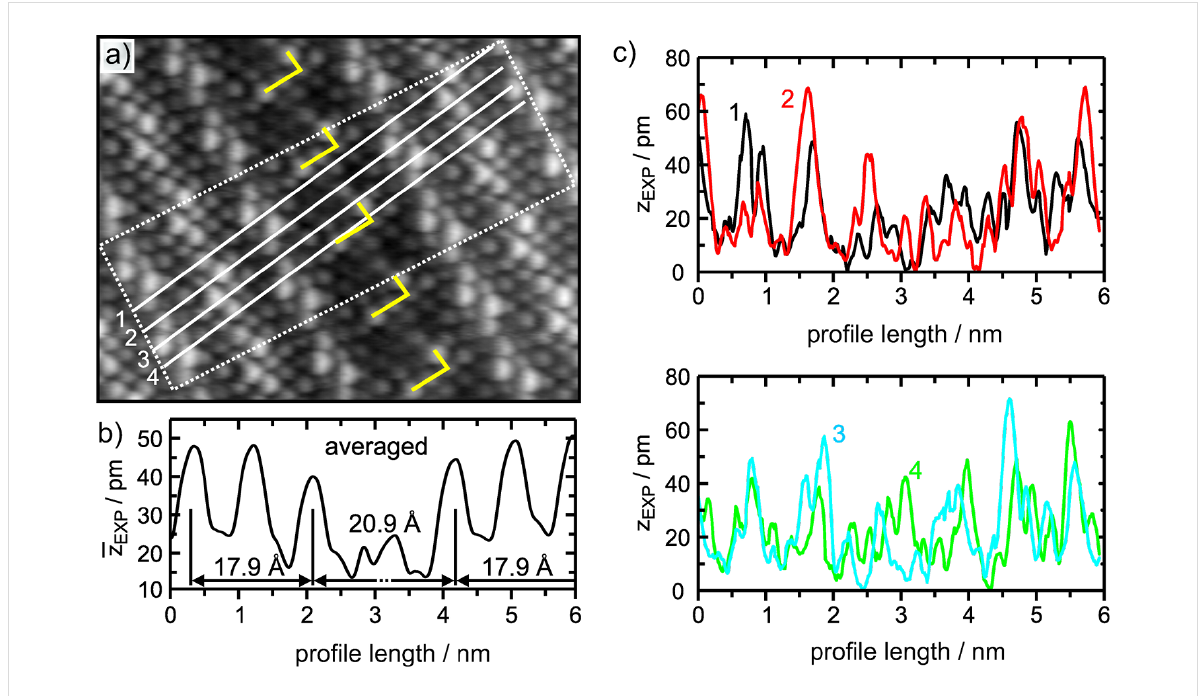
Figure 11: Height pro fi les. a) Cutout from Figure 10. White lines indicate positions where line pro fi les have been taken across the type I boundary. b) Averaged line pro fi le taken within the rectangle (two unit cells in width) in the frame above. This emphasizes that such boundaries are reproduced as depressions within NC-AFM images. Averaging was performed over 167 line pro fi les. c) Single pro fi les along chains of O atoms across the APDB marked by white lines in the rectangle in (a). Such atom rows show heights different from average terrace height. Only the pro fi le labeled 4 shows nearly no decrease in height over the